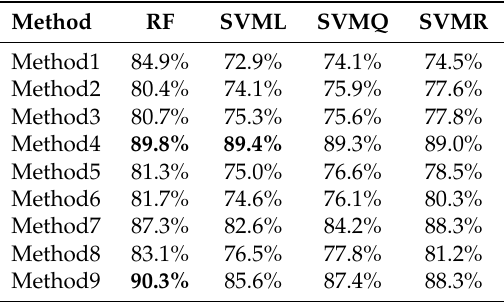
Figure 8. Spectrograms with paths (marked in white) and lines (black) generated by the evaluated methods (Section 3.2.4). We took deceleration as an example for illustration purposes. The horizontal axis represents time, the vertical axis represents frequency, and gray level represents the magnitude; the higher the luminance level, the higher the magnitude. Table 1. Classification accuracy for speed changes for 24 features describing lines, depending on the method of determining the line. The three best results are shown in